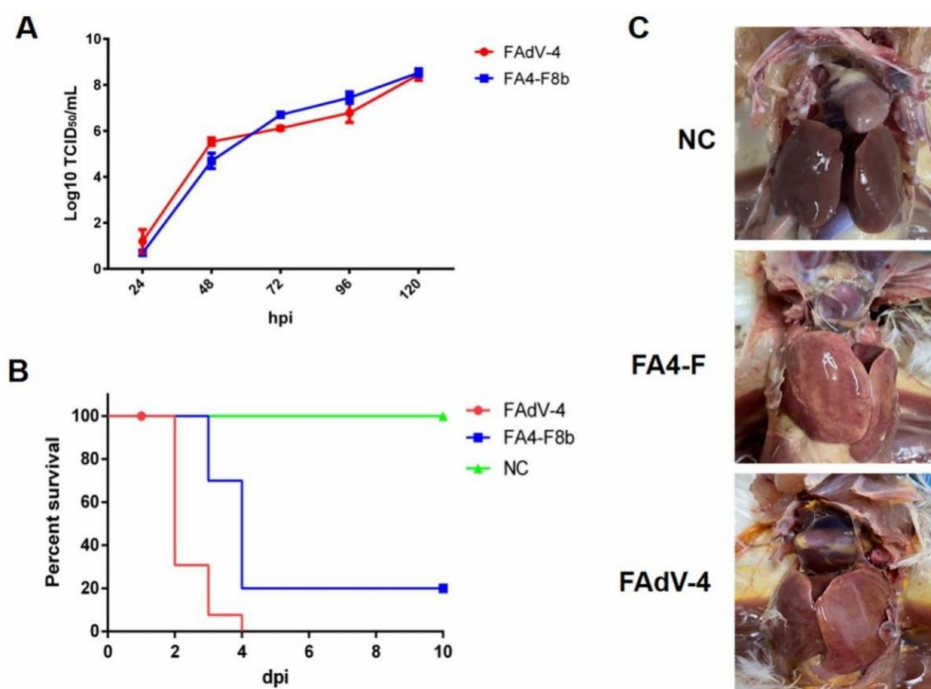
Figure 2. FA4-F8b replicated efficiently in vitro and was pathogenic in vivo. ( A ) LMH cells were infected with FA4-F8b and FAdV-4 at the same dose, respectively, and the viral supernatant collected from the infected LMH cells at the indicated time points were then titrated by TCID 50 . ( B ) SPF chickens were randomly divided into three groups and then inoculated with FA4-F8b, WT FAdV-4, and 1% culture medium, respectively. Percent of survival for these infected chickens was calculated according to the result of the infection study. ( C ) The representative gross lesion in the heart and liver from the chickens infected with FA4-F8b, the chickens with FAdV-4 and the chickens inoculated with 1% culture medium,